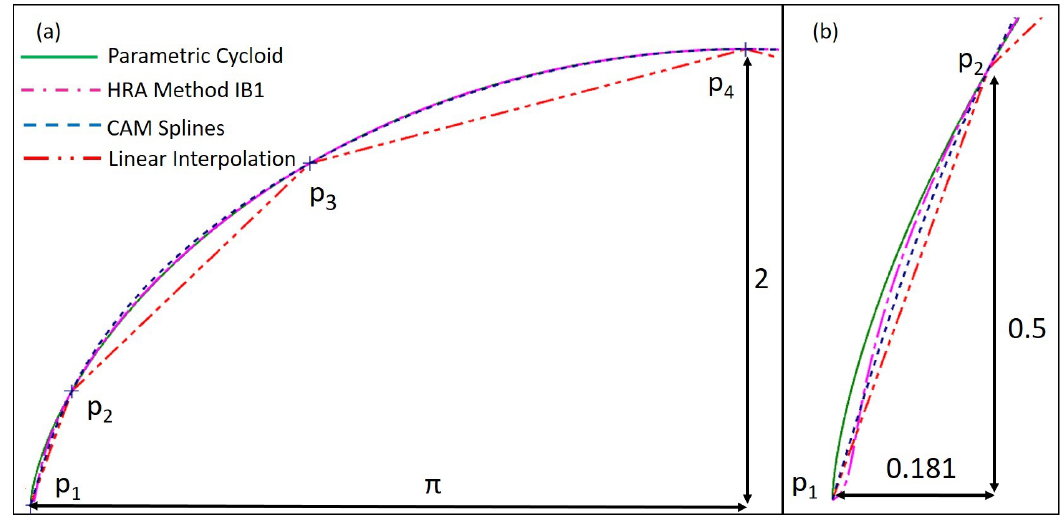
Figure 6. ( a ) Resultant interpolated curves obtained for n + 1 = 7, represented for t ∈ ( 0, π ) ; ( b ) resultant interpolated curves obtained for n + 1 = 7, in the first non-data